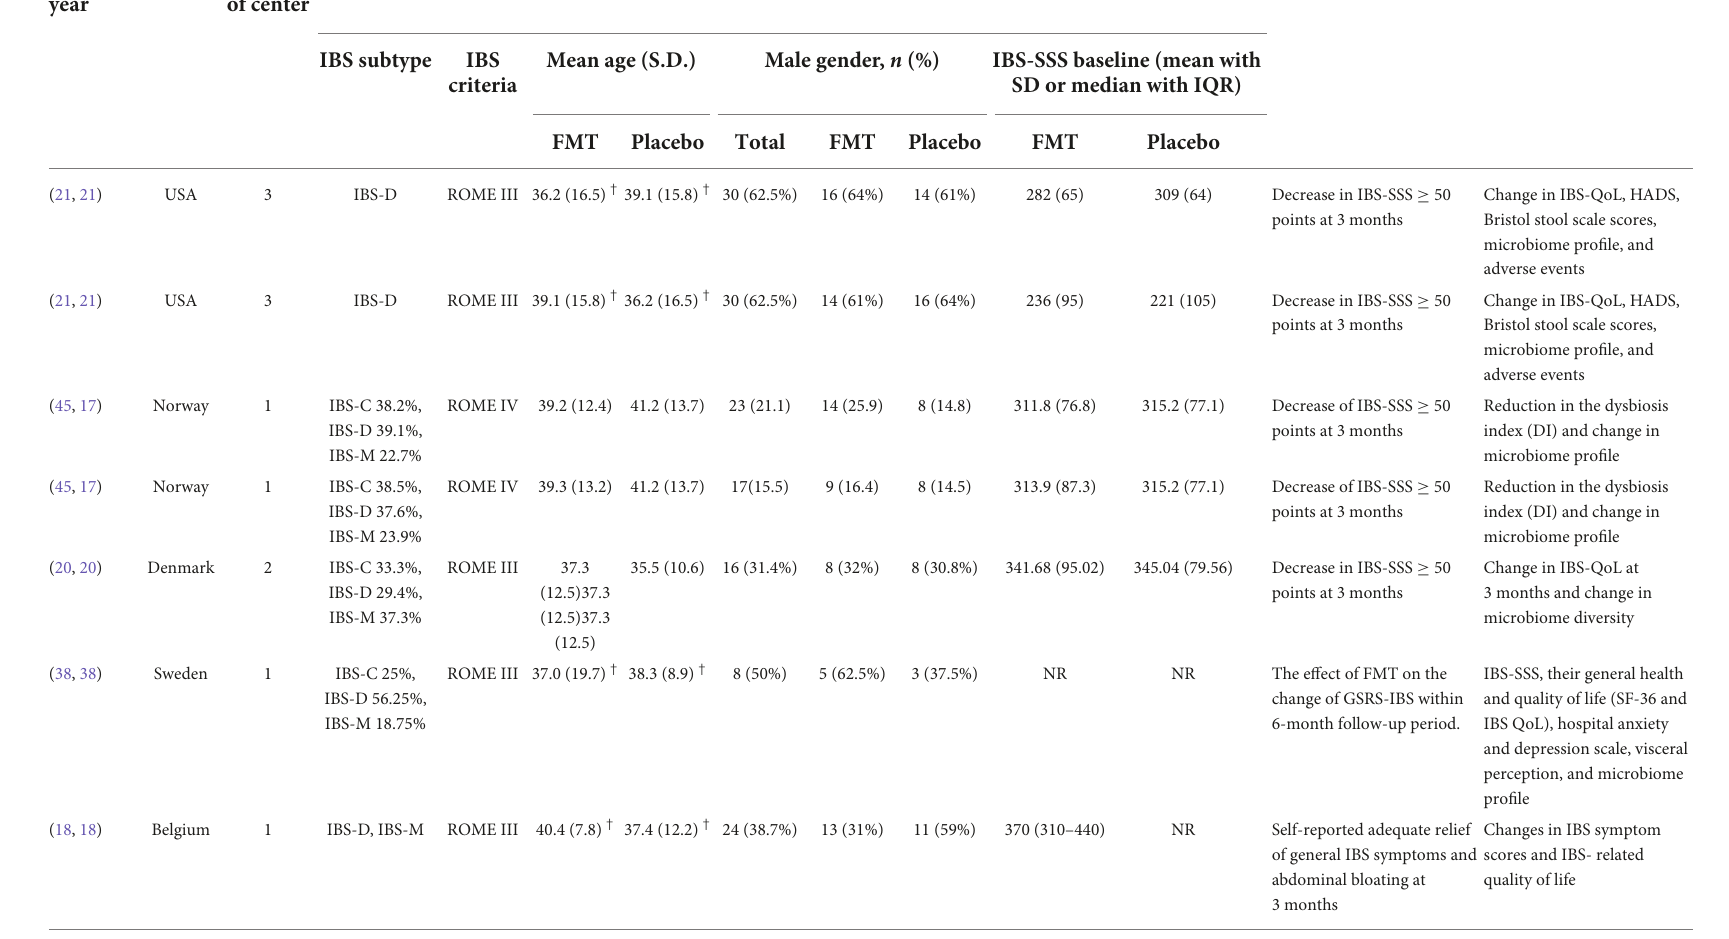
TABLE 2 Summary of the descriptive characteristics of the included